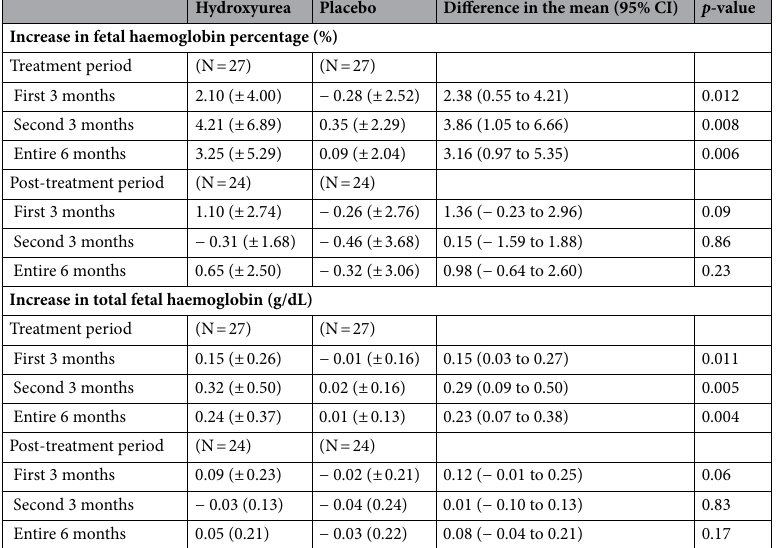
Hydroxyurea Placebo Difference in the mean (95% CI) p -value Increase in fetal haemoglobin percentage